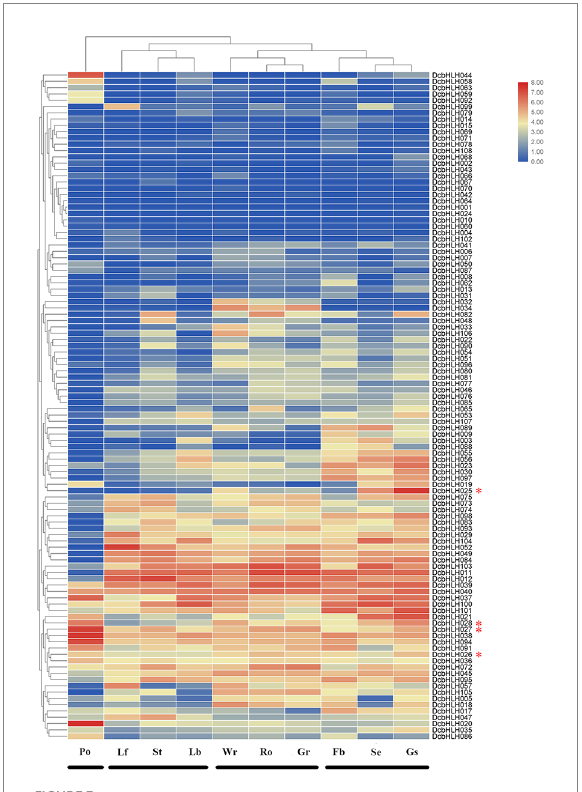
FIGURE 3 Relative expression analysis of the DcbHLH genes in different tissues. Expression patterns of DcbHLH genes in 10 Dendrobium catenatum tissues and organs. Lf, leaf; Ro, root; Gr, green root tip; Wr, the white part of the root; St, stem; Fb, flower bud; Se, sepal; Lb, labellum (lip); Po, pollinia; and Gs, gynostemium